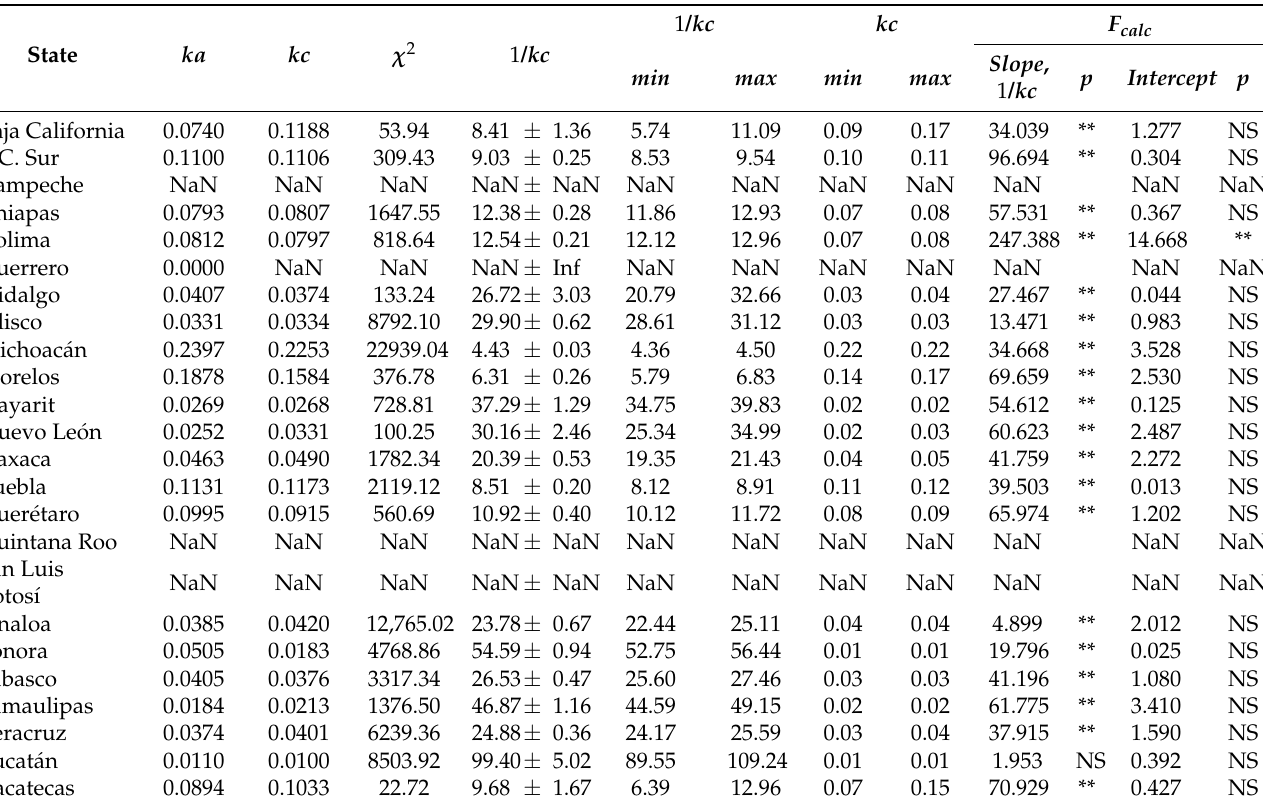
Table 3. Estimated values of common k , considering all the citrus producing states in Mexico and their weekly records of Diaphorina citri adults captured per